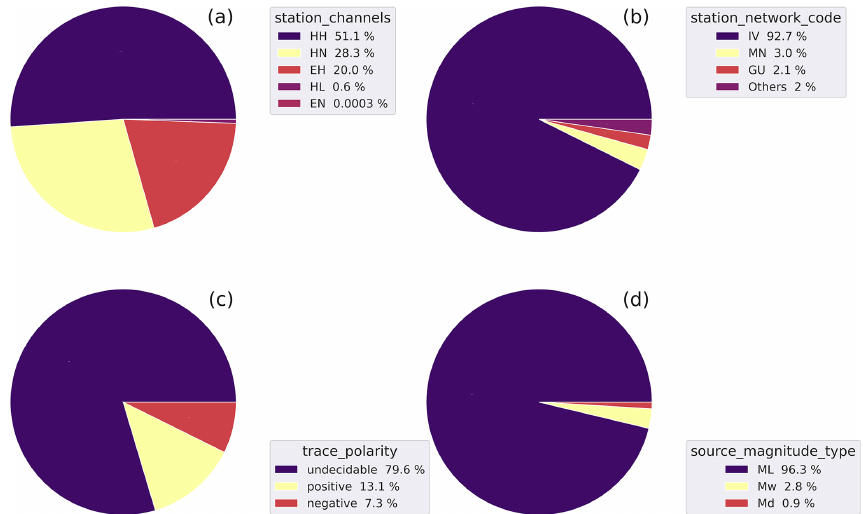
Figure 5. Pie diagrams of the earthquake dataset summarizing the distribution of the channels (a) , the data contributing networks (b) , the P-wave polarities (c) , and the magnitude types (d) of the dataset. The full list of station_network_code with % < 1 collected in “Others” in decreasing order is OX, ST, SI, XO, NI, IX, OT, RF, YD, TV, B1, AC, HL, ZM, and 3A. See the metadata names listed in Table 2 for the specific metadata being represented.